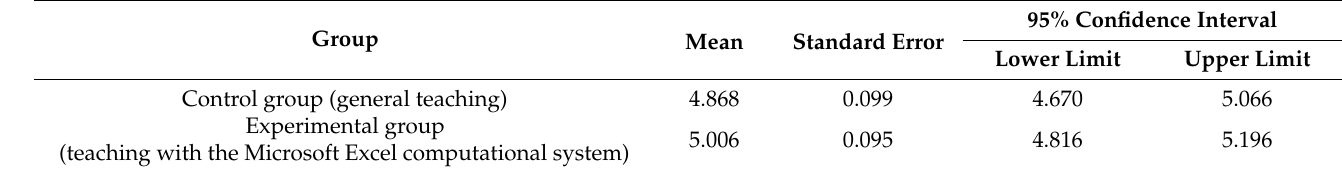
Table 6. Marginal mean after factor (group) adjustment.